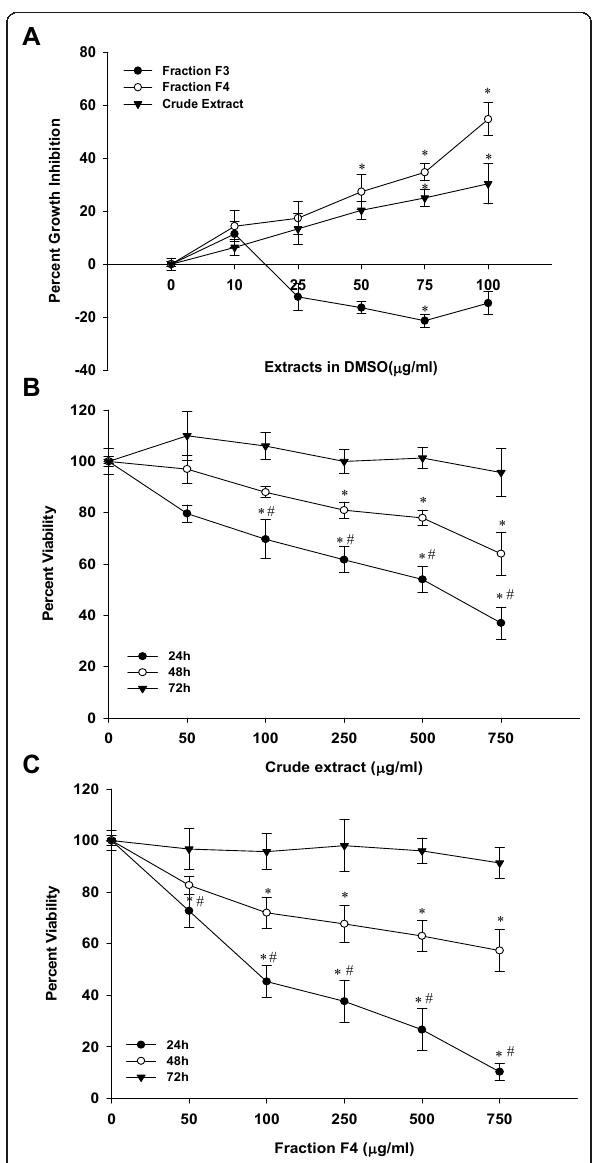
Figure 2 Dose-dependent effect of B. pinnata leaf extract and its chromatographic fraction on the viability of human cervical cancer cells . A . HeLa cells incubated in 96 well plate without or with indicated concentration of B. pinnata crude leaf extract or its fraction F3 and F4 were examined for cell viability at 24 h by MTT assay as described in Methods. Percent growth inhibition was measured w.r.t. untreated controls. B and C . HeLa cells incubated with increasing concentration of crude extract (B) and fraction F4 (C) were examined for cell viability at 24 h, 48 h and 72 h and their percent viability was measured by MTT assay. The results are representative of three independent experiments with similar results. Values are mean ± SD of the triplicate cultures. *p < 0.05 versus untreated cultures. #p < 0.05 versus cells treated at similar dose of crude extract or fraction F4 treatment at 48 h or 72 h